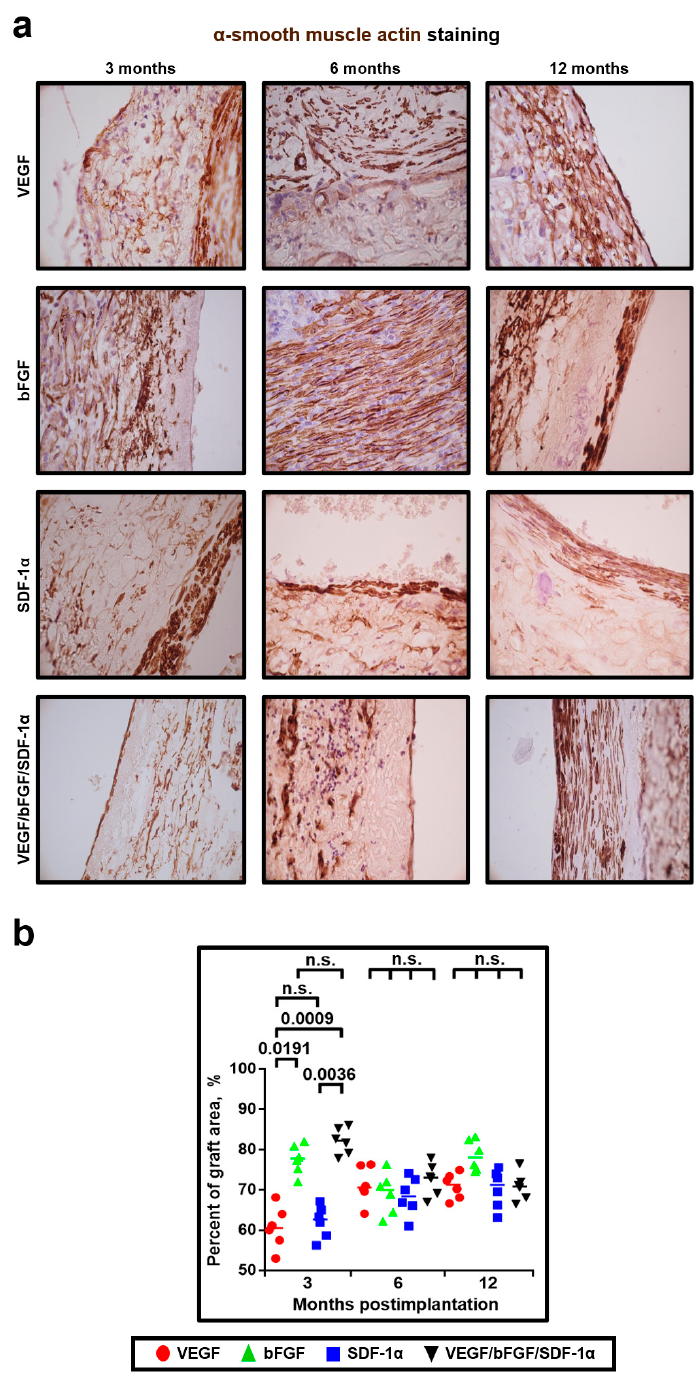
Figure 9. bFGF accelerates formation of a smooth muscle cell layer. ( a ) Representative images of α -SMA- (brown) stained grafts modified with either VEGF, bFGF, SDF-1 α , or all three factors at 3, 6 and 12 months postimplantation; ( b ) Quantitative image analysis, data are represented as a univariate scatterplot with the median, each dot represents a count from one image, Kruskal–Wallis test with the further Dunn’s multiple comparisons test, p values adjusted for multiple comparisons are reported in a numerical manner, n.s. is for not significant.